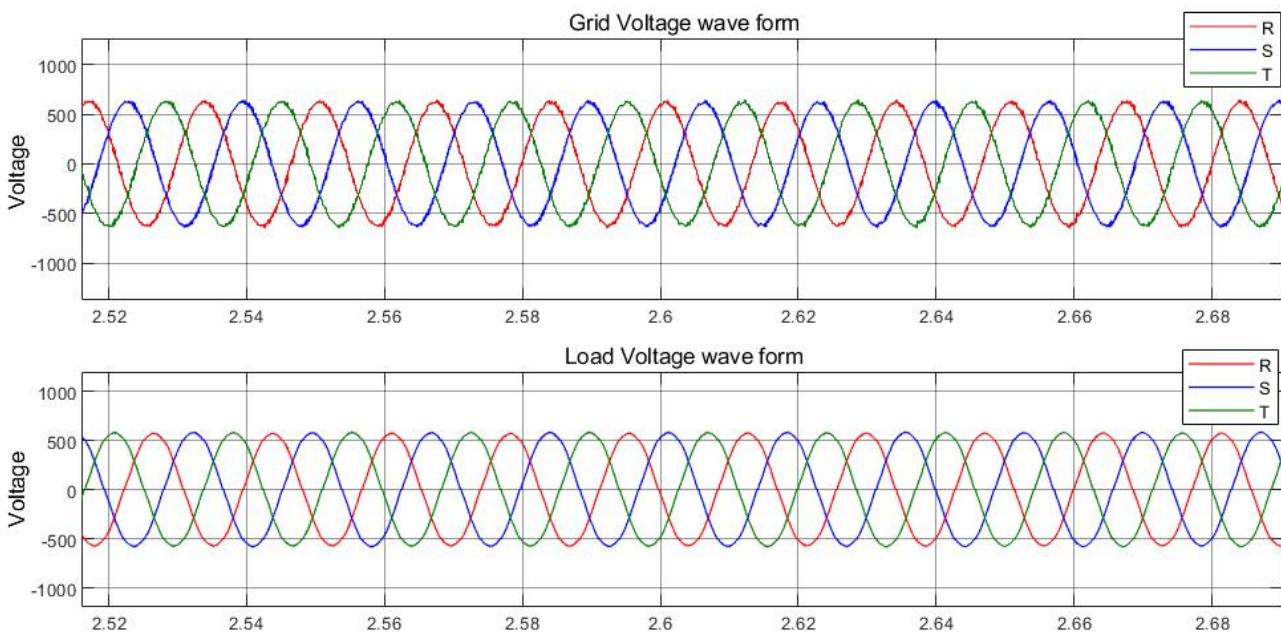
Figure 16. Load ‐ side voltage and grid ‐ side voltage with non ‐ linear load on the grid side using PWM.